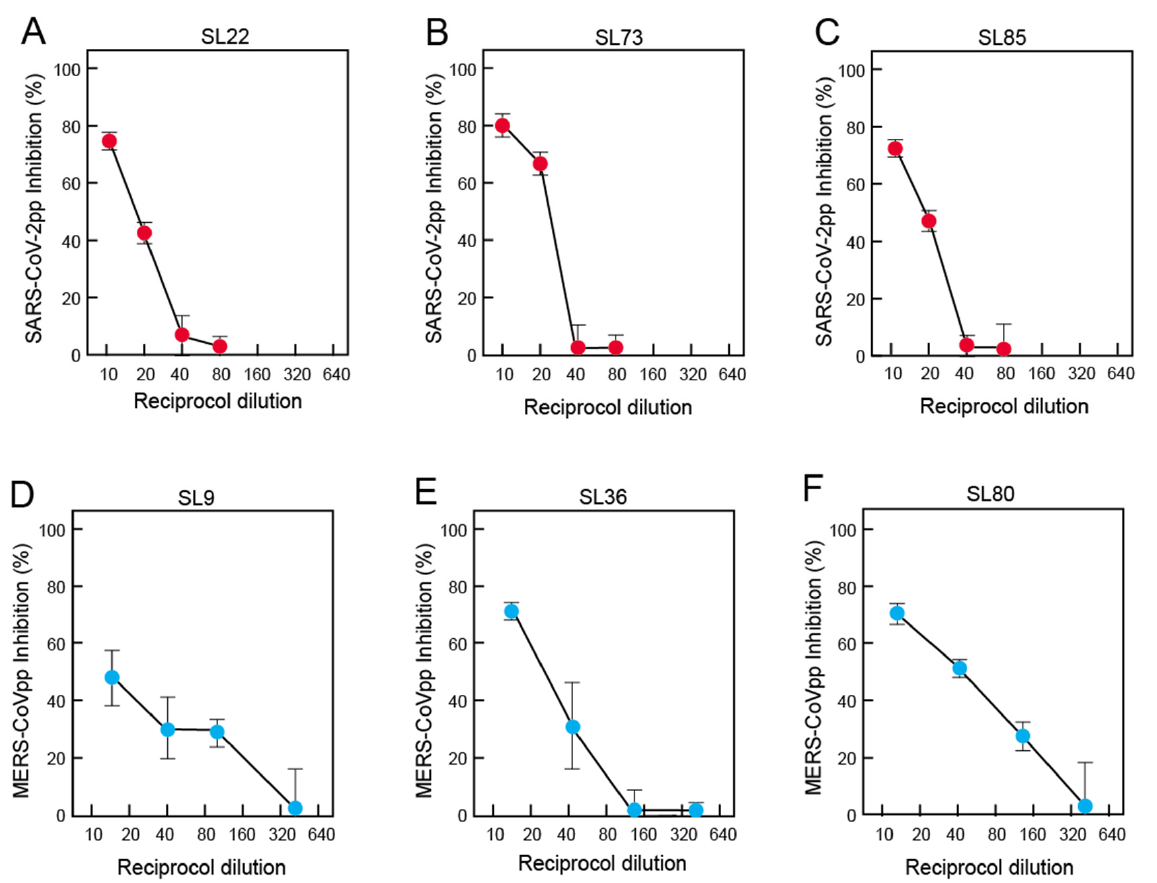
Figure 6. Neutralization of pseudoviruses expressing SARS-CoV-2 and MERS-CoV spike. SARS-CoV-2 pseudovirus neutralization curves were determined with samples from the following subjects: ( A ) SL22, ( B ) SL 73, and ( C ) SL83. MERS-CoV pseudovirus neutralization curves were determined with samples from the following subjects: ( D ) SL9, ( E ) SL36, and ( F ) SL 80.